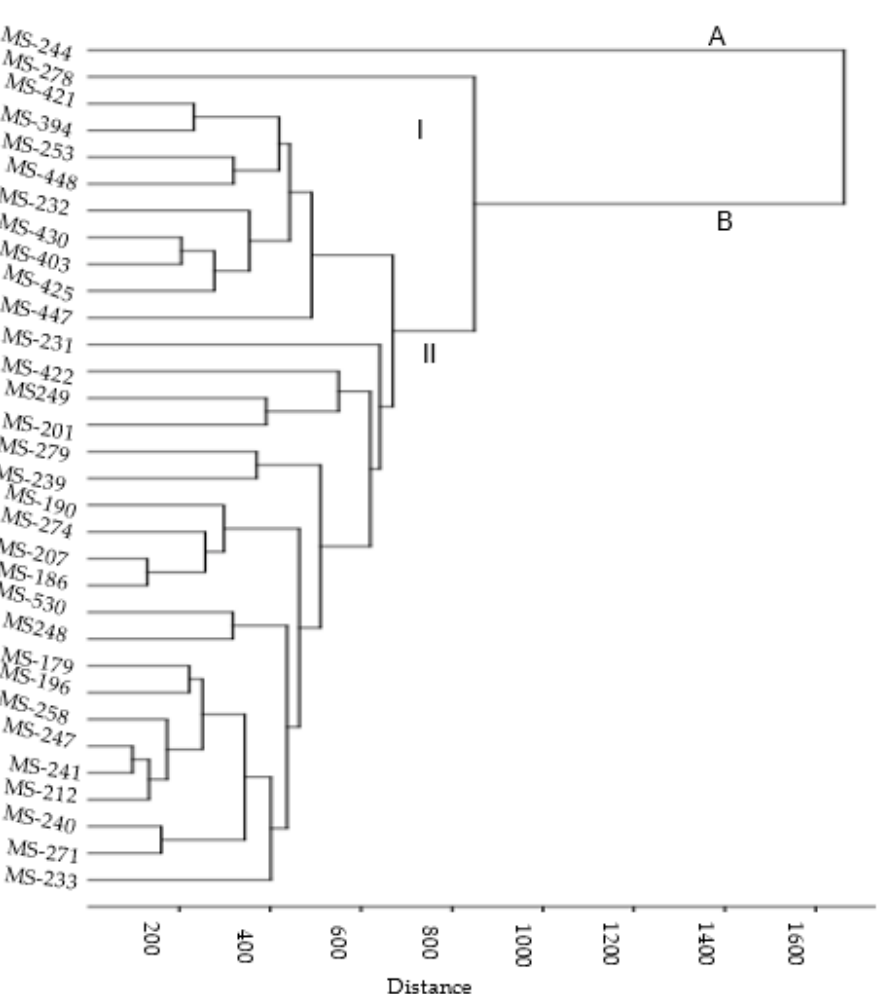
Figure 5. Dendrogram of morphological traits using UPGMA clustering in the selected accessions of M. sacchariflorus based on phenolic compounds.